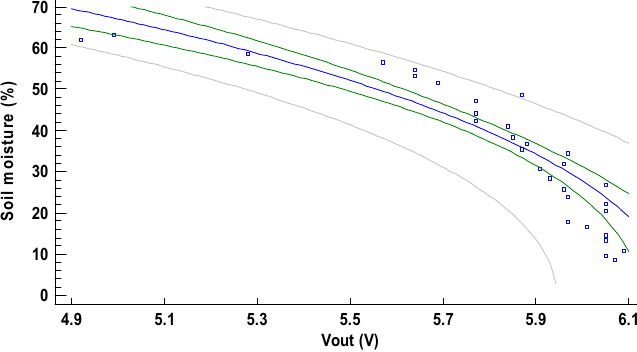
Figure 31. The Vout in the frequency of 760 kHz in prototype NP3.